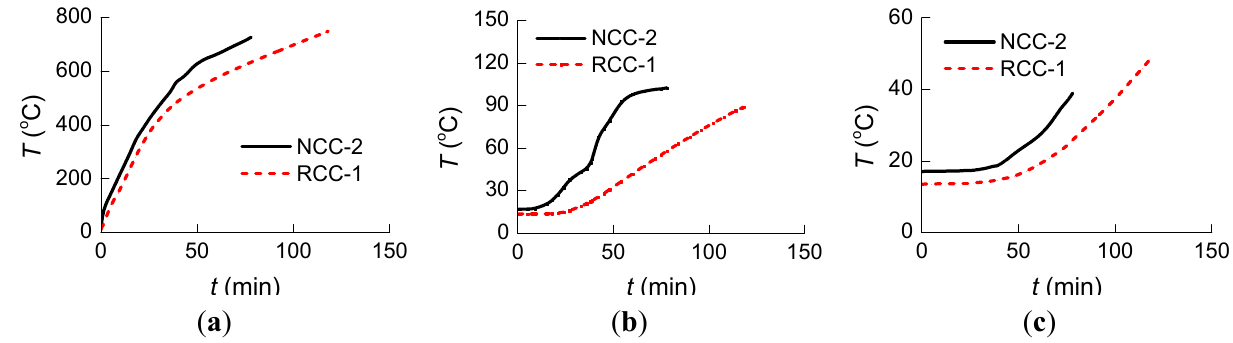
Figure 8. Measured temperature vs. time for NCC-2 and RCC-1 at the three measure points: ( a ) Measure Point 1; ( b ) Measure Point 2; and ( c ) Measure Point 3.